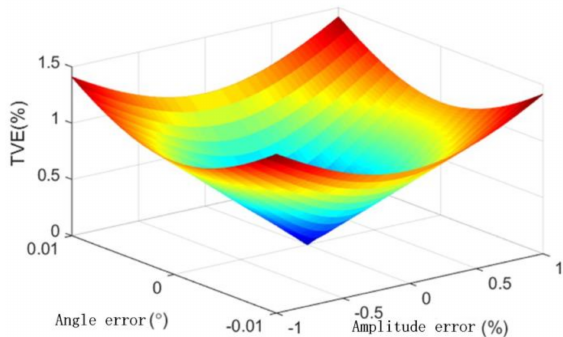
Figure 3. Total vector error (TVE) on the relationship between the amplitude error and angle error.